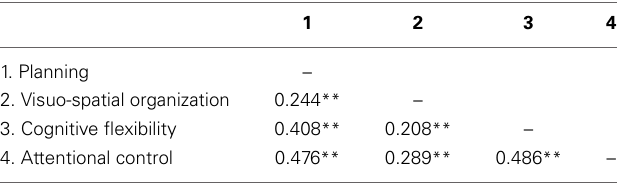
Table 14 | Correlations for dependent variables in the